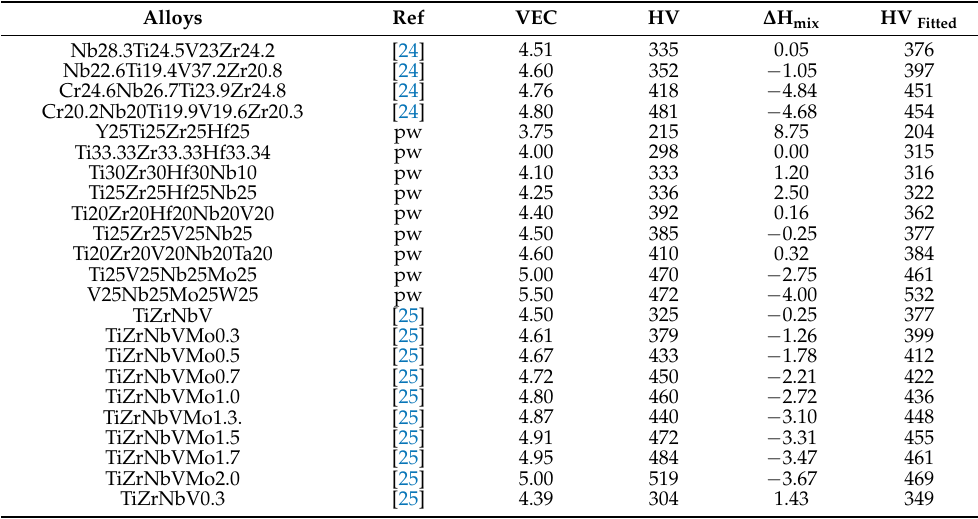
Table 2. HV data (kgf/mm 2 ) together with the VEC and ∆ H mix (kJ/mole) for the samples of the present work and those taken from the